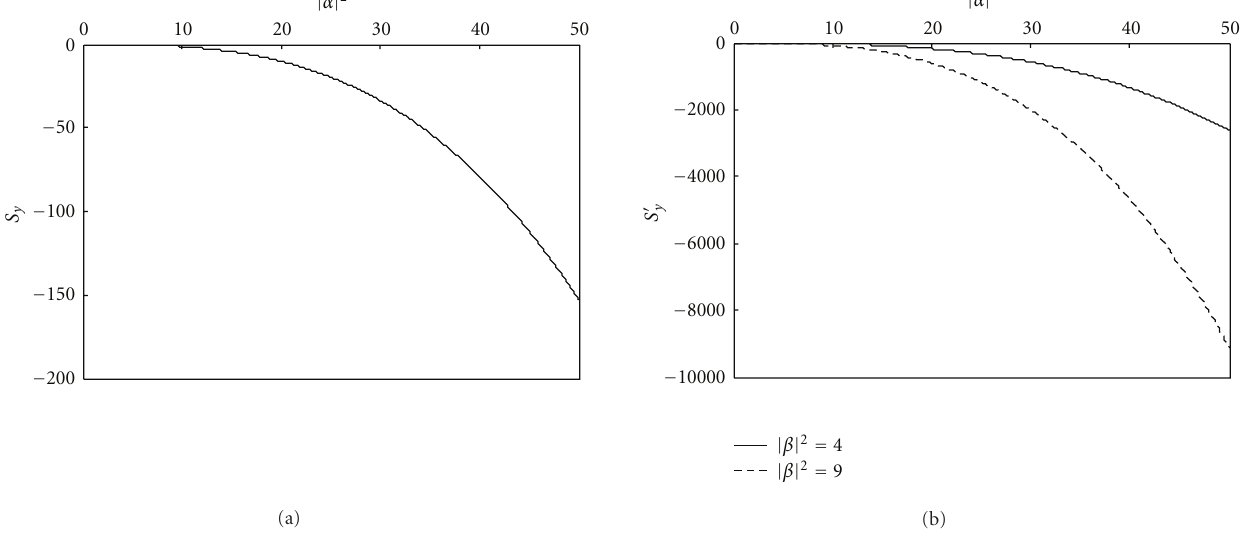
Figure 3: Dependence of amplitude-squared squeezing (a) s y with | α | 2 in spontaneous and (b) s (cid:6) mixing